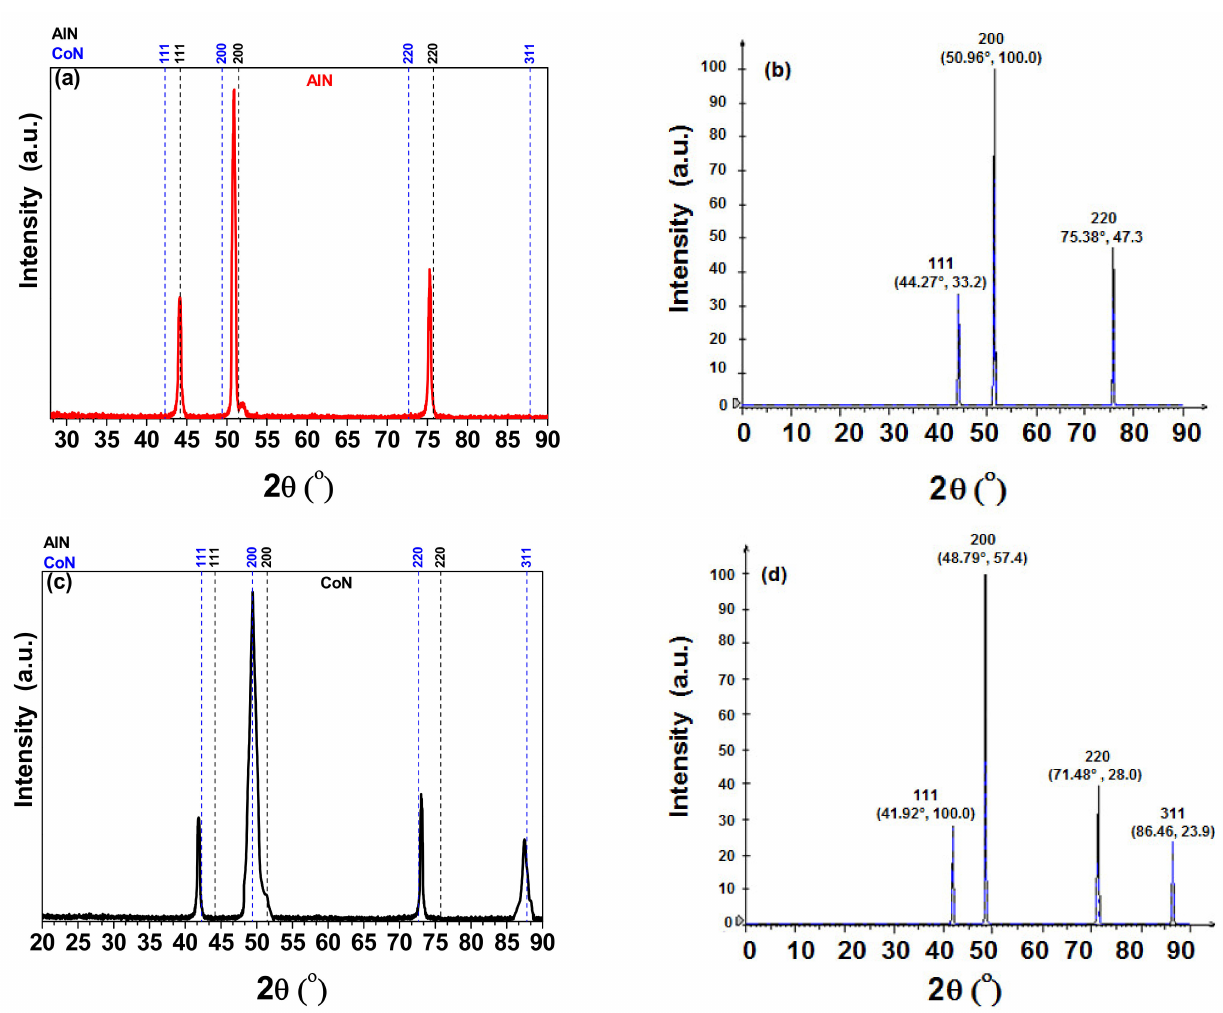
Figure 8. Diffraction patterns obtained for all coatings: ( a ) AlN diffraction pattern (experimental), ( b ) AlN diffraction pattern (simulated), ( c ) CoN diffraction pattern (experimental) and ( d ) CoN diffraction